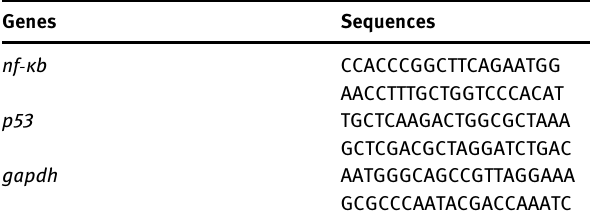
Table 2: The primers sequences utilized in this